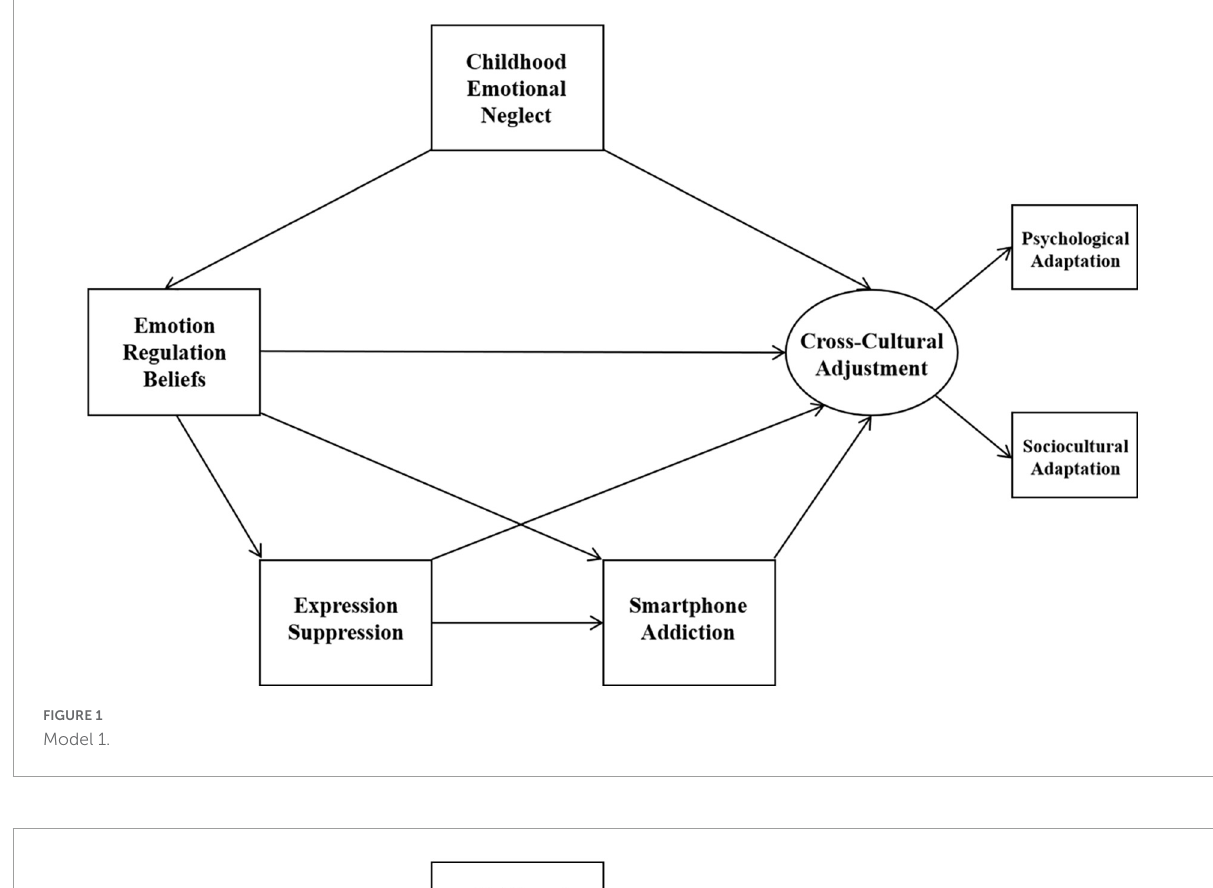
FIGURE1 Model 1.